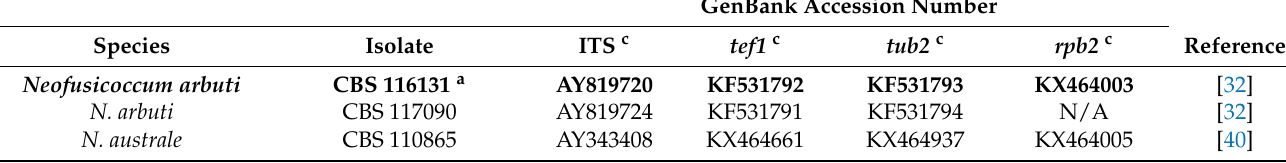
Table 1. Strains obtained in this study and downloaded from GenBank with accession numbers used for phylogenetic